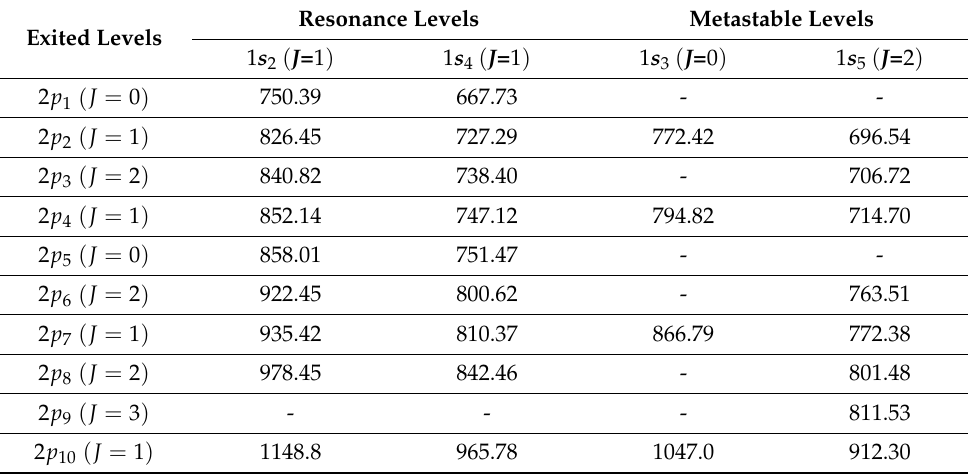
Table 5. Light wavelengths (nm) generated during Ar (3 p 5 4 p → 3 p 5 4 s ) transformation.